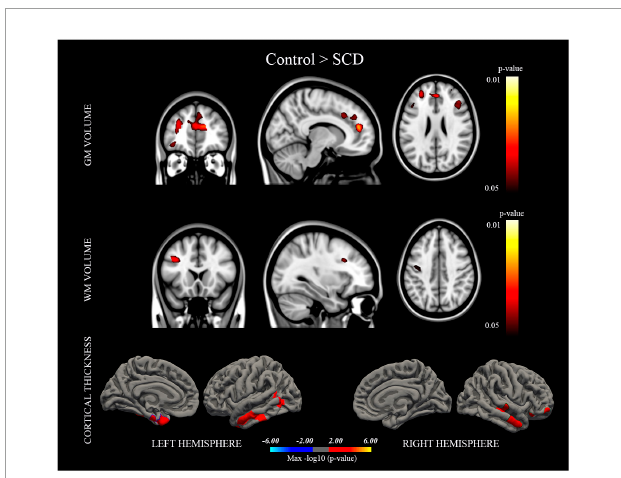
FIGURE1 Brain regions in which the control group displayed significantly higher gray matter/white matter (GM/WM) volume and cortical thickness than the subjective cognitive decline (SCD) group. Results were considered statistically significant at p <